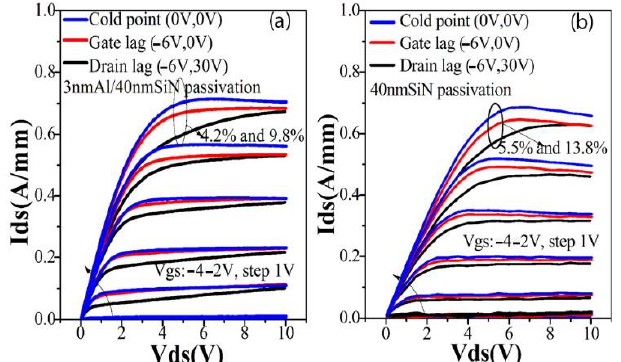
Figure 30. The gate lag and drain lag of ( a ) Al/SiN passivated and ( b ) SiN passivated AlGaN/GaN HEMT devices were measured at different passivation layers. Reproduced with permission [153].